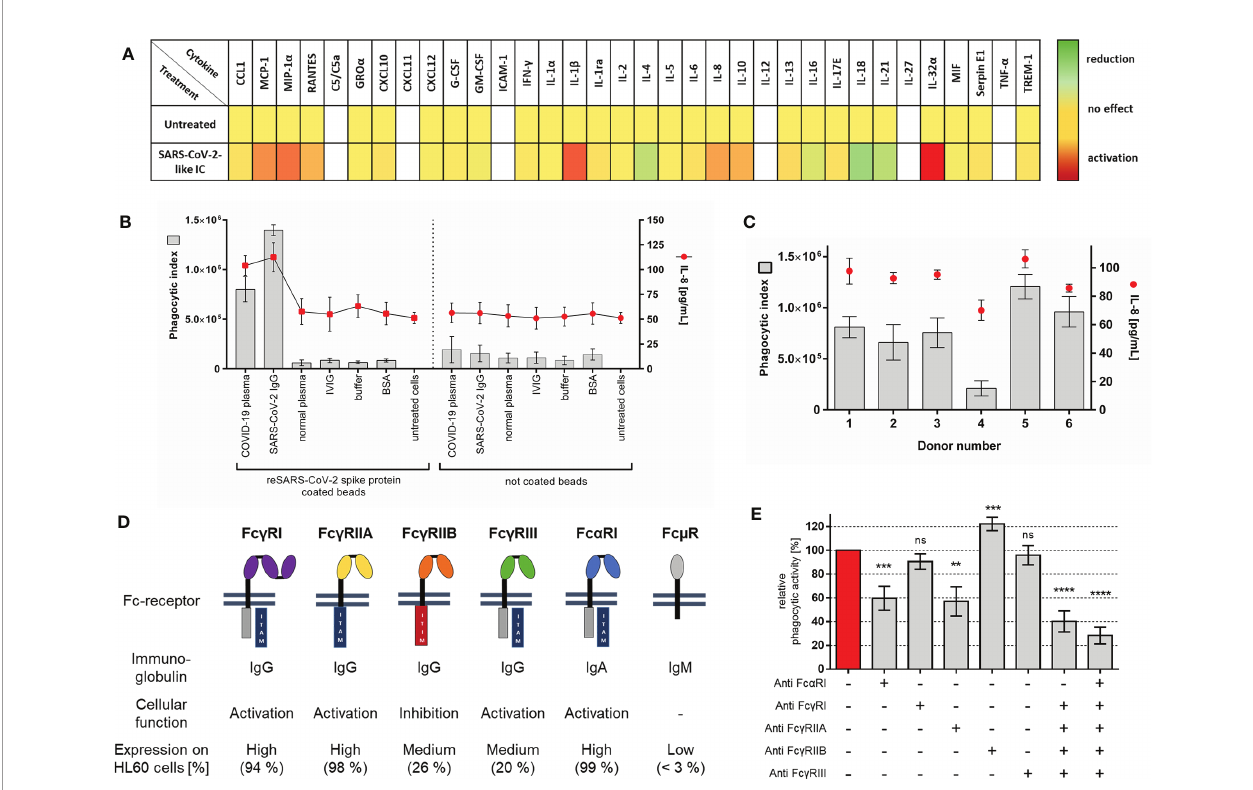
FIGURE 2 | Establishment of COVID-19 like in fl ammation model (A) Heat map of chemokines and cytokines secreted by neutrophil-like HL60 cells after stimulation with anti-SARS-CoV-2 IgG-IC. HL60 cells were stimulated for 18 h at 37°C with the indicated immune complex. Qualitative cytokine secretion was measured by using human cytokine arrays. Relative signal intensities for every measured cytokine of untreated cells were set as 1 (yellow). The x-fold induction (red) or reduction (green) in comparison to untreated cells was calculated. Not detected cytokines are shown in white. Results represent mean of three independent experiments. (B) Evaluation of COVID-19-like in fl ammation model. Cells were incubated for 1 h with SARS-CoV-2 spike protein coated or not coated beads opsonized with different immunoglobulins, BSA, or PBS controls. Phagocytic index (gray bars, left y-axis) for bead uptake and corresponding IL-8 release (red dots, right y-axis) in cell culture supernatant were measured. Data represents mean of eight independent experiments. (C) Analysis of phagocytic activity and IL-8 release with different COVID-19 plasma donors [experimental procedure as in (B) ]. (D) Overview of human Fc-receptors (FcR), immunoglobulin binding speci fi city, cellular function, and their expression on neutrophil-like HL60 cells. Fc-receptor expression on HL60 cells, 4 days differentiated with 1.3% DMSO, was measured as percentage of positive cells; results represent mean of three independent experiments. (E) FcR blocking experiments with COVID-19 plasma opsonized SARS-CoV-2-like particles. Cells were pre-incubated with 5 µg/ml of indicated blocking antibodies or combinations of those 20 min before addition of immune complex. Phagocytic index of not blocked cells was referred as 100% phagocytic activity, and the remaining phagocytic activity is shown as mean of six independent experiments. Statistics: One way ANOVA; Dunetts multiple comparisons test, 95% con fi dence interval. ns, not signi fi cant, **p ≤ 0.01, ***p ≤ 0.001, ****p ≤